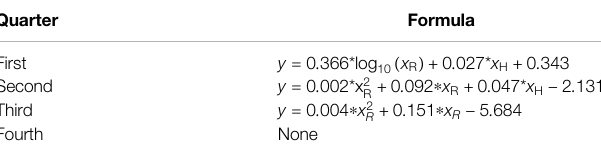
TABLE 2 | Correction formulas of the study area.